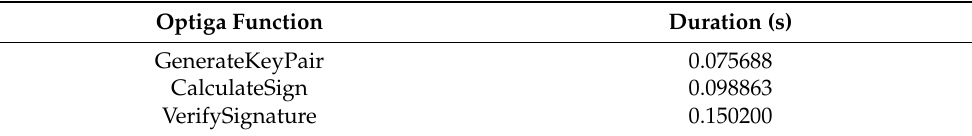
Table 2. Measurements of the executed Optiga Trust X functions related to the ECDSA-based authentication scheme.